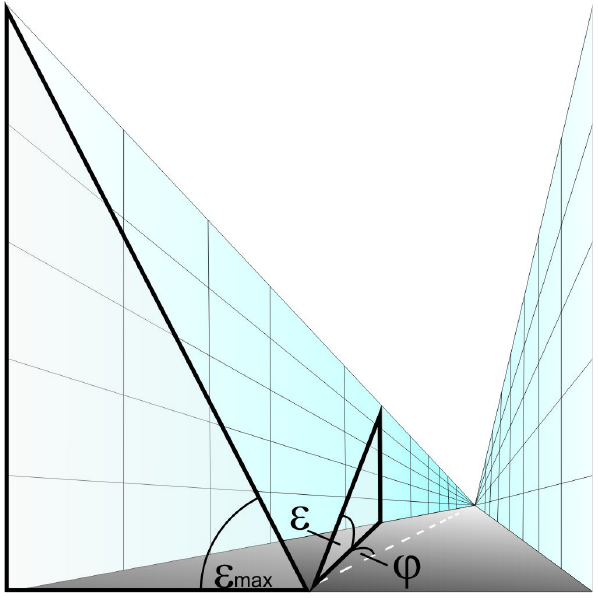
Fig. 1. Angles used to describe the illumination in a street